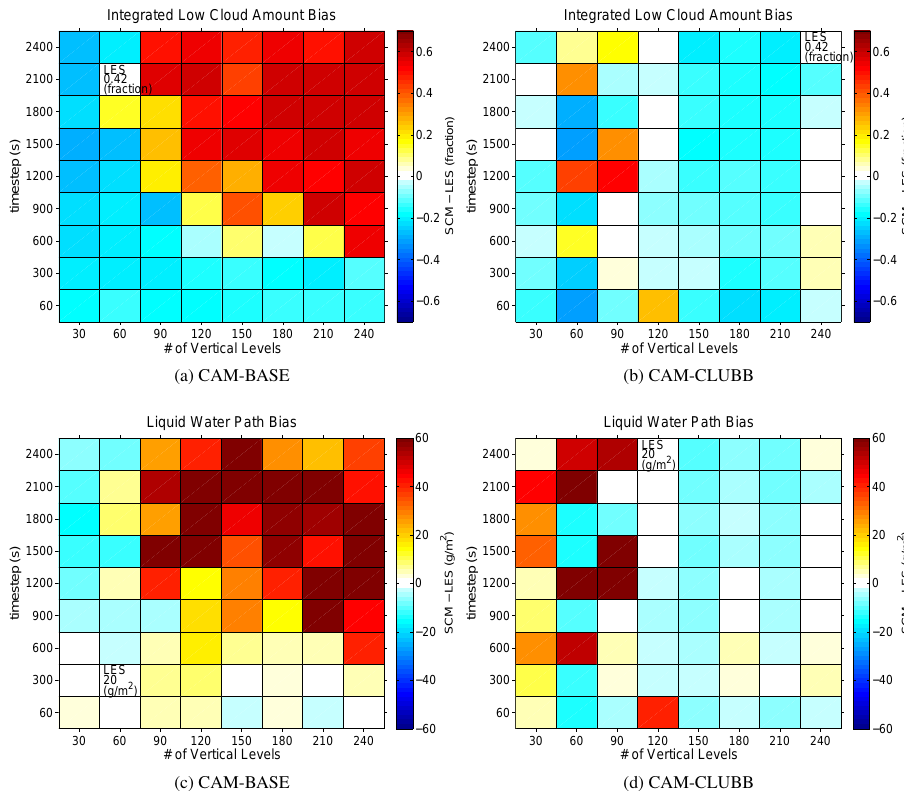
Fig. 5: Same as Fig. 1 except averaged over hours 4–8 of the simulation for the ATEX case of cumulus under stratocumulus.